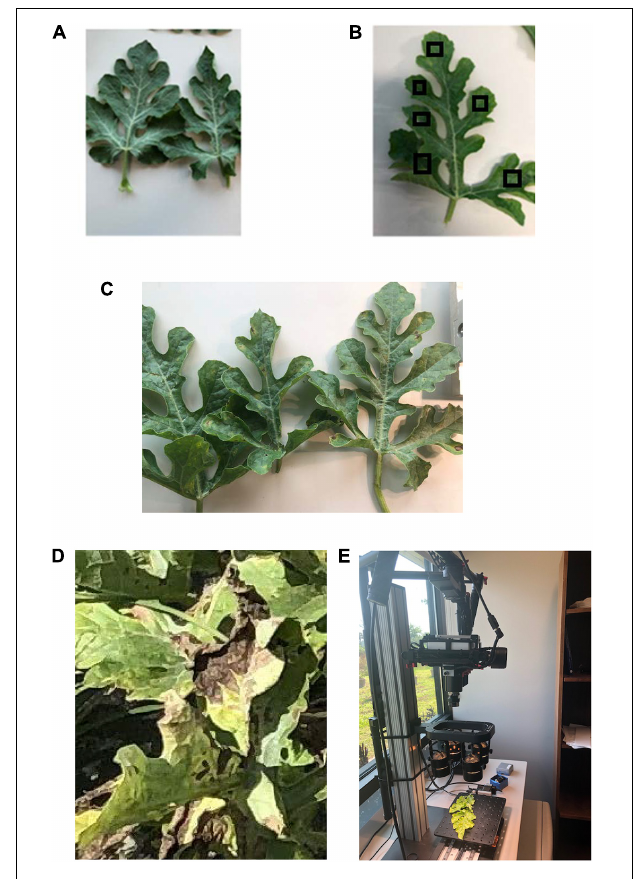
FIGURE 1 | (A) Healthy watermelon leaves and downy mildew infected leaves in different severity stages (as examples): (B) low (this image includes examples of regions of interest, RoIs); (C) medium; and (D) high. (E) Hyperspectral data collection in the laboratory by a Pika L2 (Resonon Inc., Bozeman MT, United States) hyperspectral